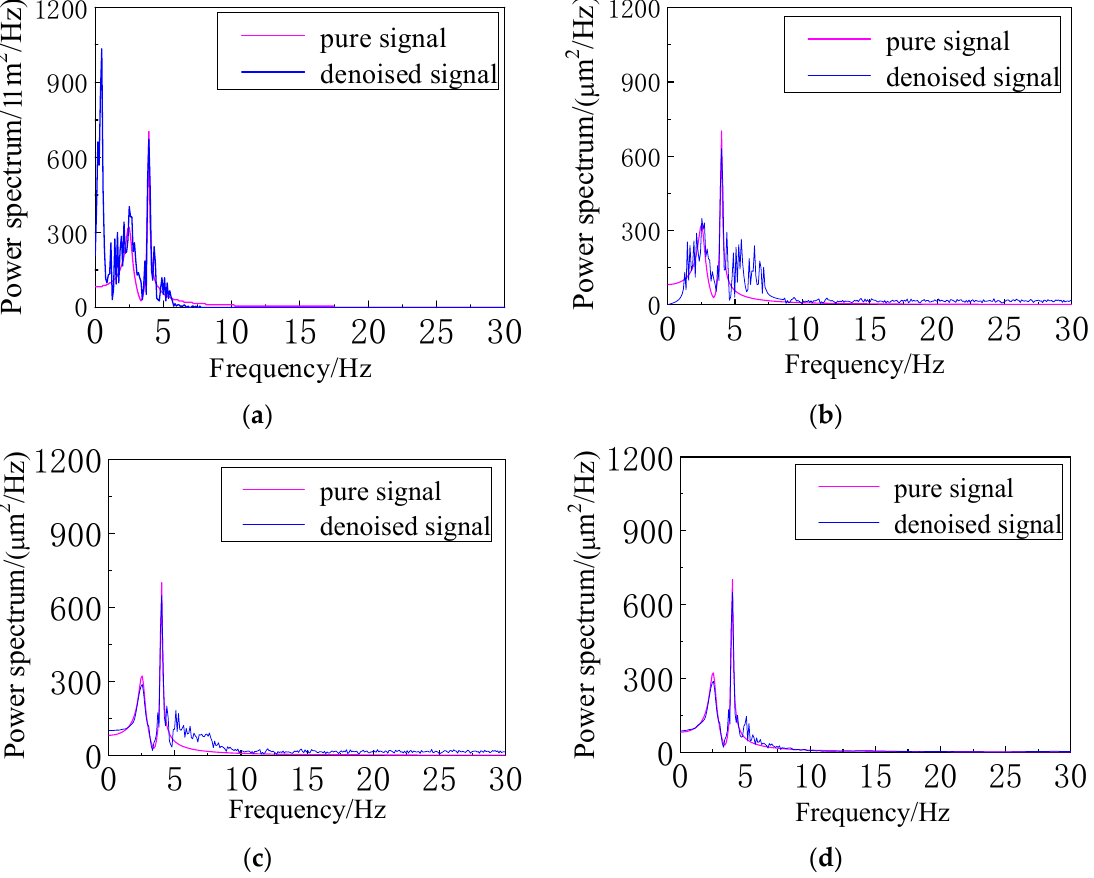
Figure 4. Power-spectrum comparison of four filtering methods for the noised signal f ( t ). ( a ) Result of SVD; ( b ) Result of EEMD; ( c ) Result of CEEMDAN; ( d ) Result of CEEMDAN-SVD.